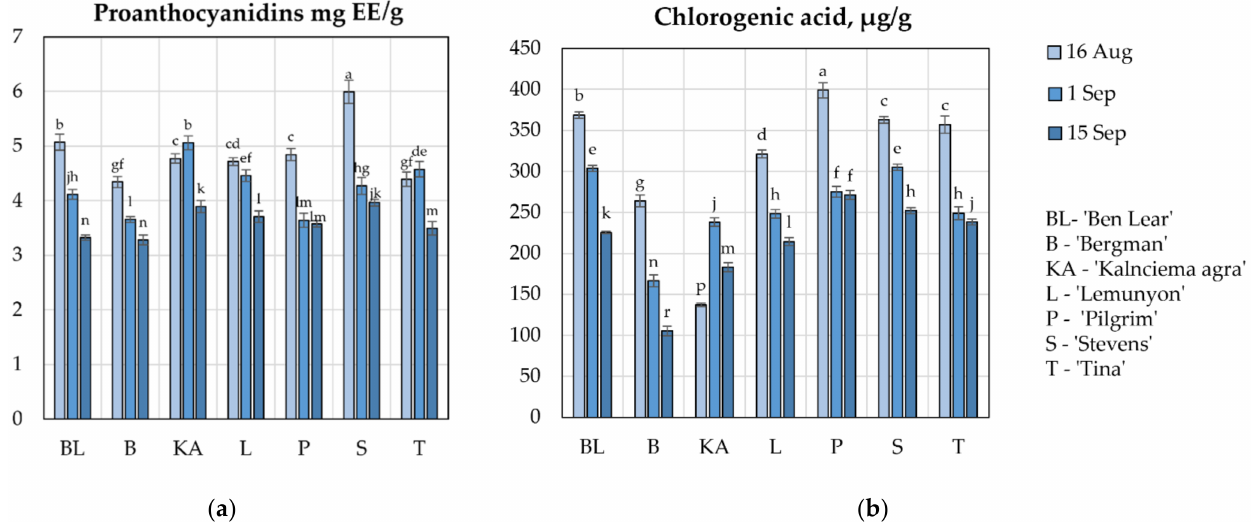
Figure 3. ( a ) Variability in the quantitative compositions of proanthocyanidins in the fruit samples of the large cranberry cultivars; ( b ) Variability in the quantitative composition of chlorogenic acid in the fruit samples of the large cranberry cultivars. Different letters indicate statistically significant differences between the detected amounts of the compounds in the cranberry fruit samples ( p <